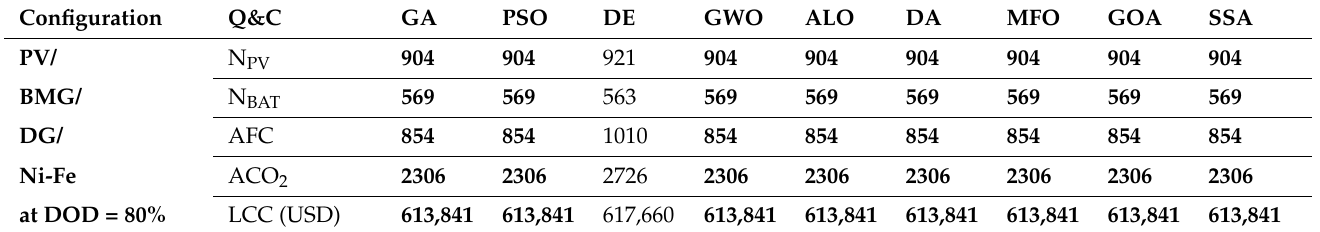
Table 10. Optimization results of the MPRAMC-based IHRES using LF strategy at LPSP value of 0%.